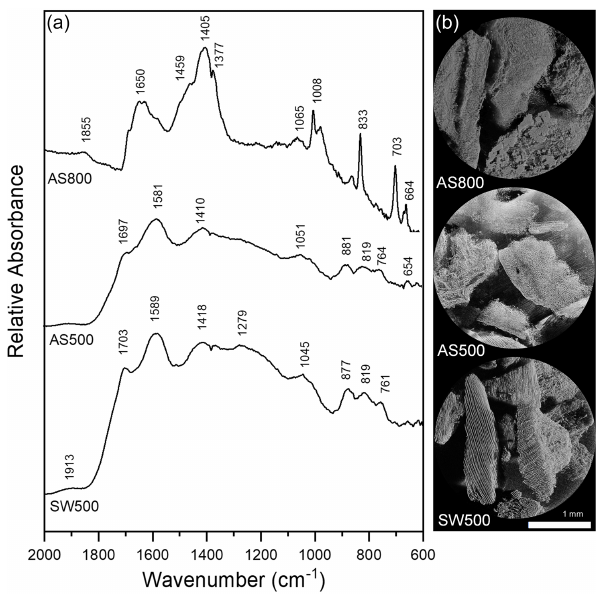
Figure 1. (a) DRIFT spectra of AS800, AS500, and SW500 biochars. Samples diluted with potassium bromide to 3% sample and collected with 256cm − 1 scans with a 4cm − 1 resolution. (b) X- ray microCT images of AS800, AS500, and SW500